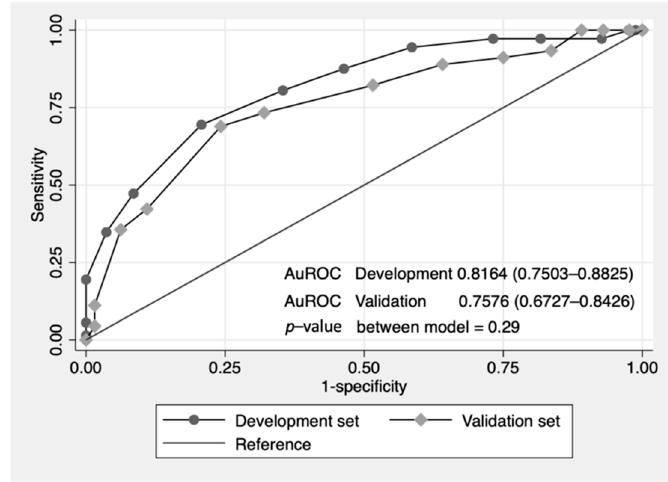
Figure 4. Comparative ROC curve of failure of nonoperative reduction of intussusceptions between the developmental set and the validation set predicted by risk scoring scheme (curved line) and a 50% chance prediction (diagonal line).